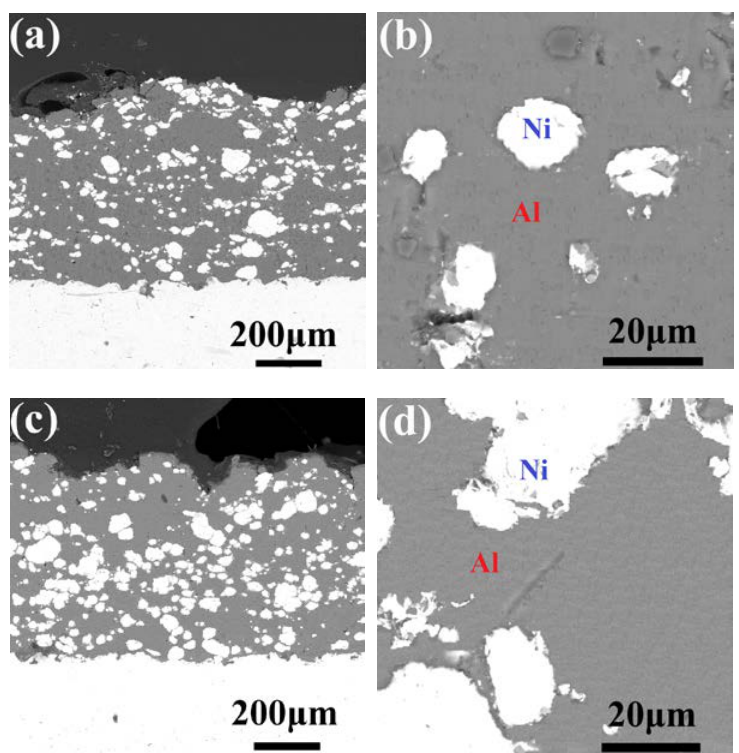
Figure 5. Cross-sectional morphologies of the cold-sprayed Ni/Al coatings at ( a , b ) 250 °C and ( c , d ) 450 °C.